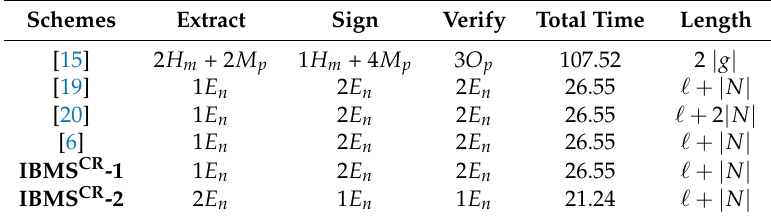
Table 2. The comparison of related work of IBMS on the computational performance.